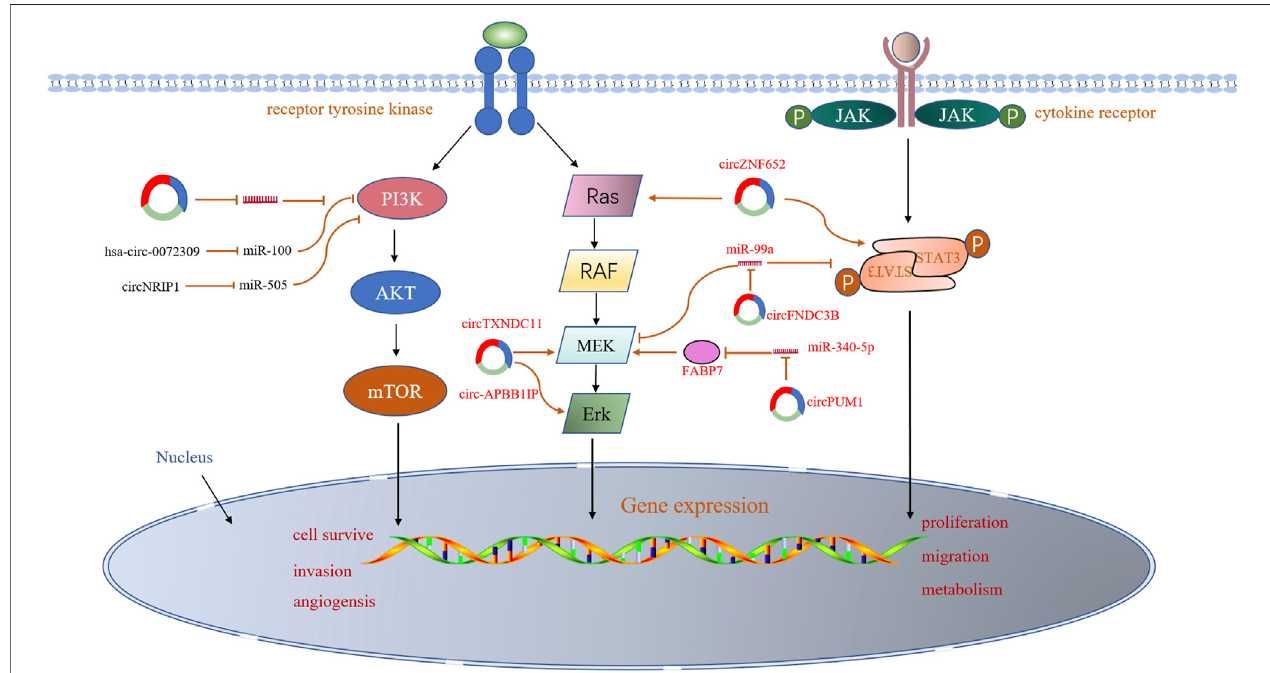
FIGURE 2 | Involvement of circRNAs in the cancer-associated signaling pathways in